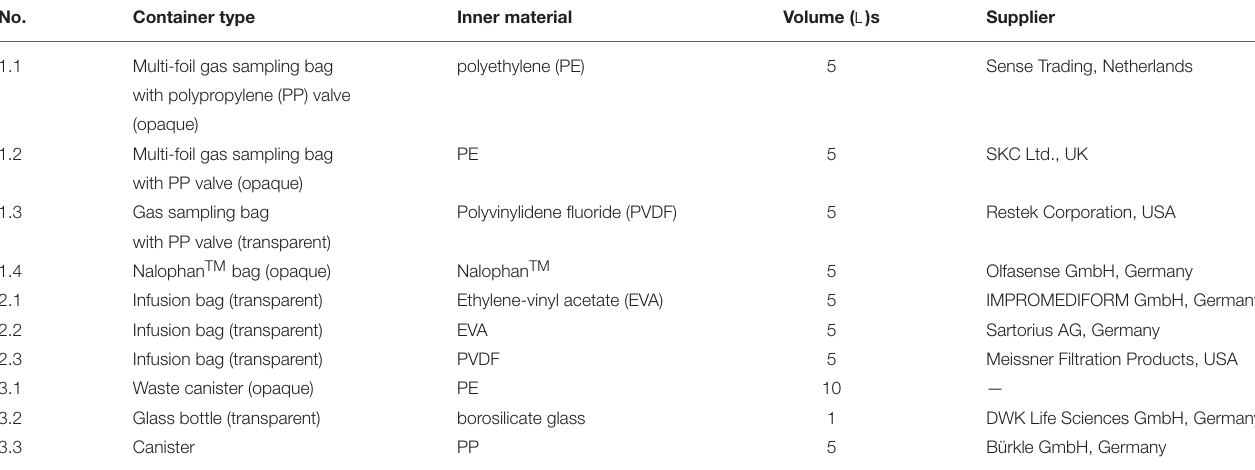
TABLE 1 | Tested containers for large-volume reference seawater